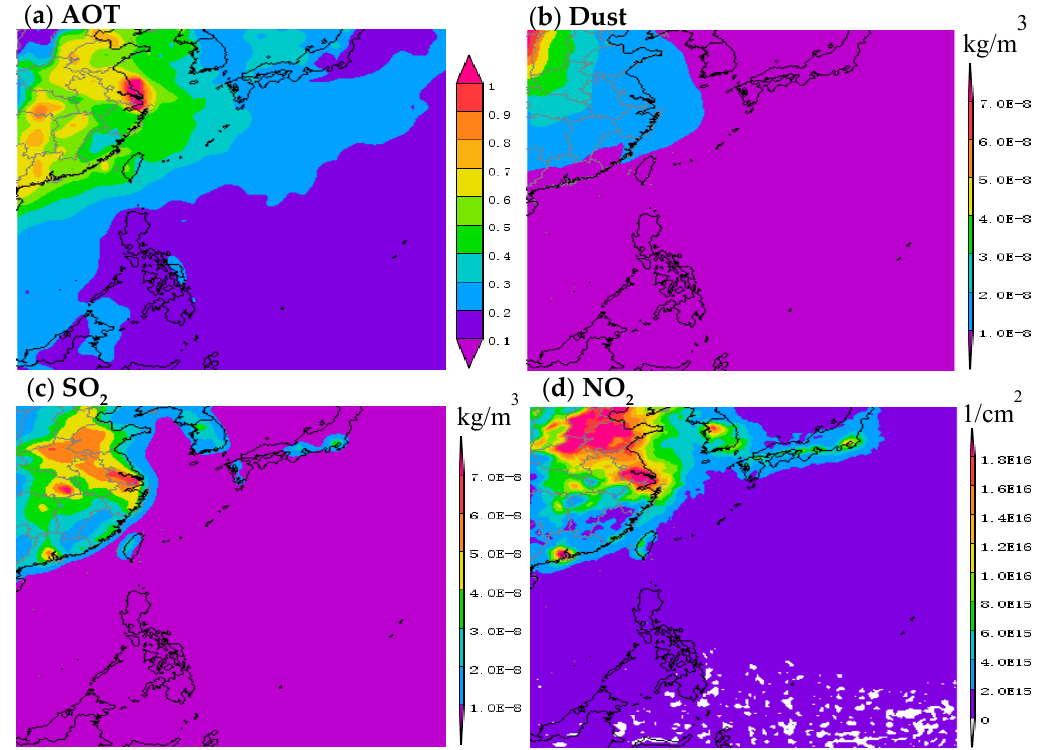
Figure 1. Distribution of seasonal average aerosol optical thickness (AOT), dust, SO 2 and NO 2 over the western North Pacific during the sampling period. Monthly AOT, dust, SO 2 products with 1 × 1° (MODIS-Terra MOD08_M3 v6), 0.5 × 0.625° (MERRA-2 Model M2TMNXAER v5.12.4), 0.5 × 0.625° (MERRA-2 Model M2TMNXAER v5.12.4) resolution, daily NO 2 products with 0.25 × 0.25° (OMI OMNO2d v003) resolution were downloaded from Giovanni (https://giovanni.gsfc.nasa.gov).